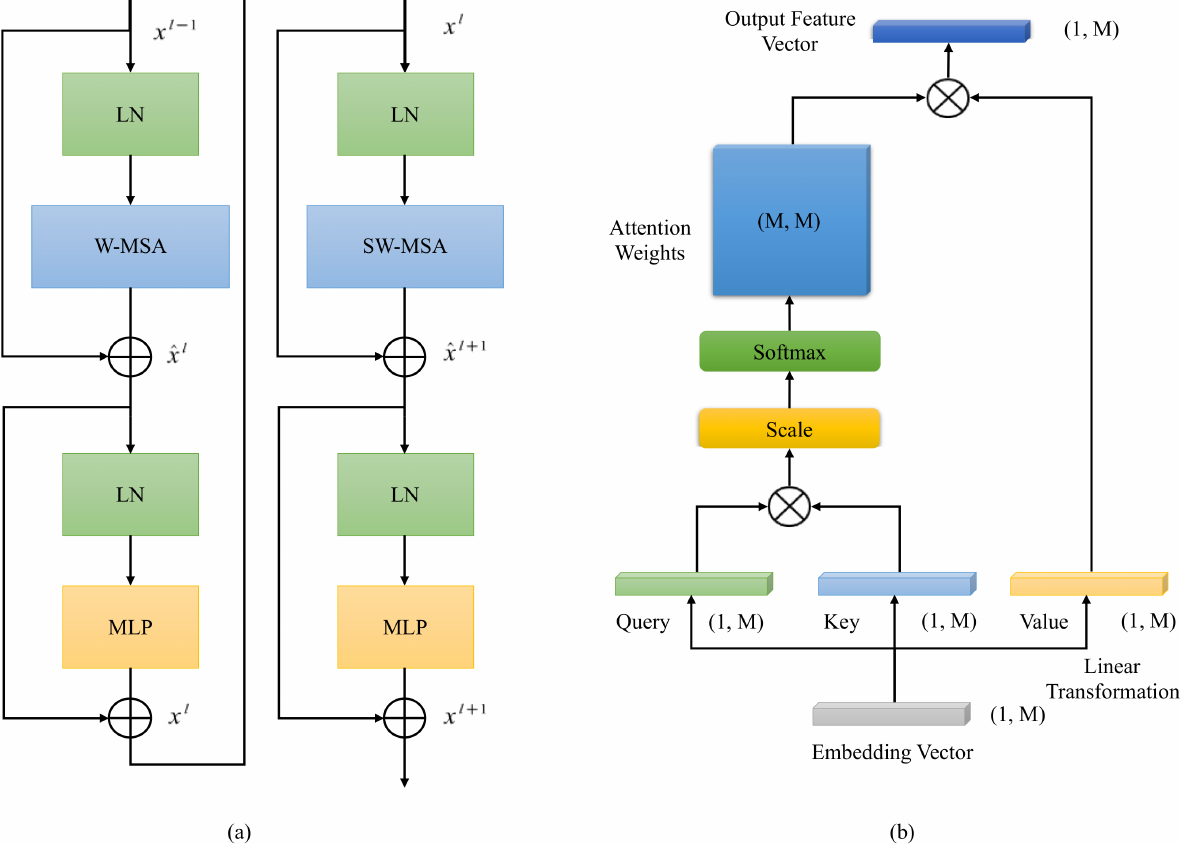
Figure 4. Overview of swin transformer block and the multi-head self-attention (MSA) module. ( a ) Architecture of swin transformer block. ( b ) Calculation flow of multi-head self-attention (MSA)